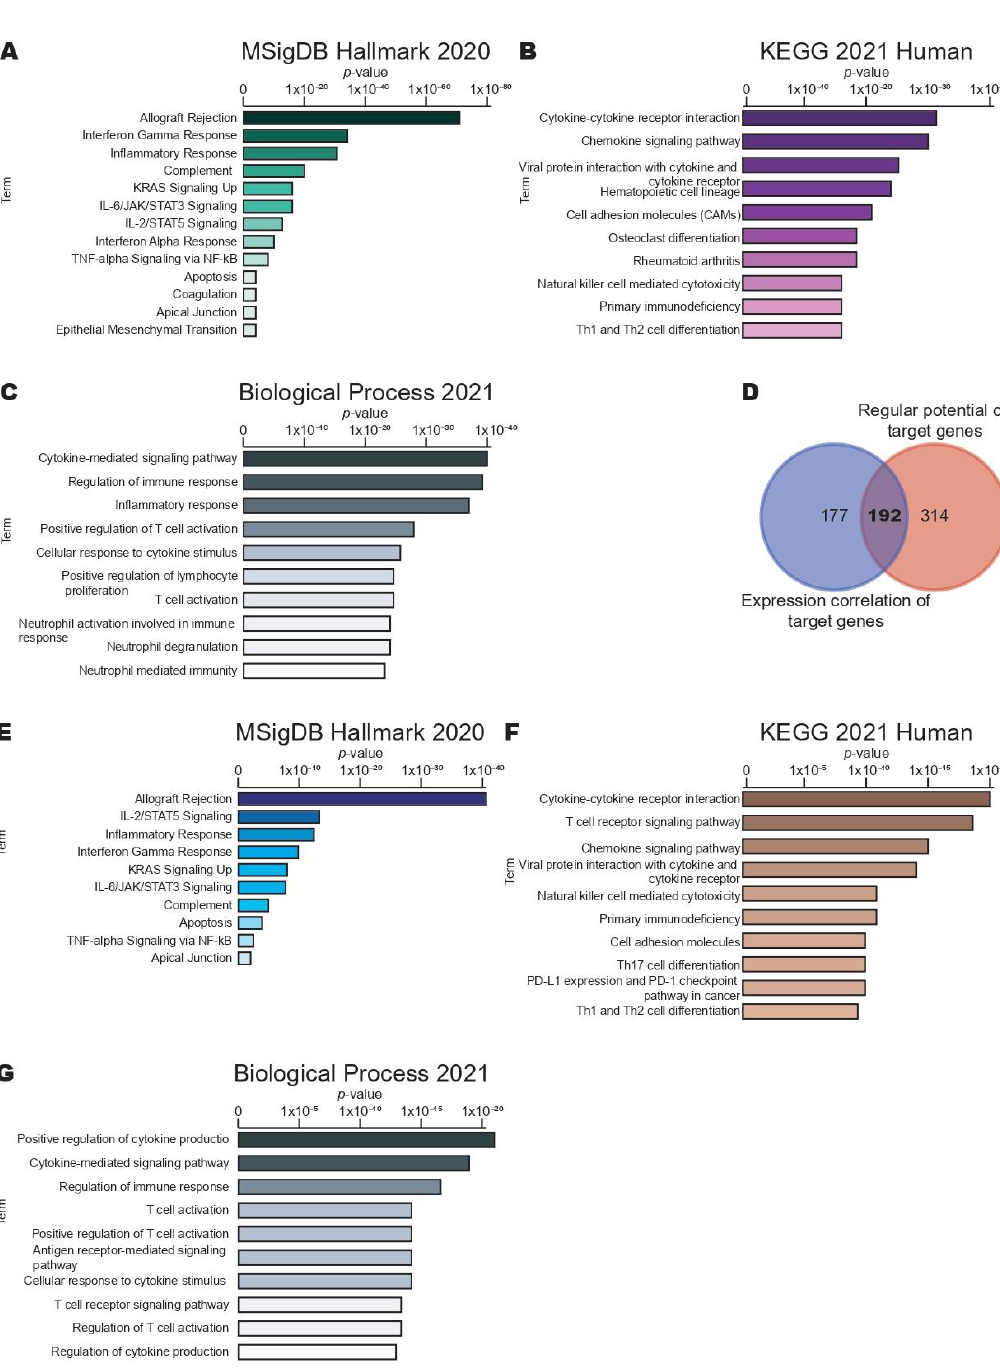
Figure 5. FLI-1 regulates the gene expression participating in the immune response in cervical cancer. ( A ) Identification of pathways according to genes that positively correlate with FLI-1 using the MSigDB Hallmark 2020 library in the Enrich database. ( B ) Validation of identified pathways of genes that positively correlate with FLI-1 using the KEGG 2021 Human library in the Enrich database. ( C ) Identification of the biological processes of genes that positively correlate with FLI-1 using the Biological Process 2021 library in the Enrich database. ( D ) Identification of genes in common considering the regular potential and expression correlation of target genes using the CISTROME database. ( E ) Identification of pathways of genes identified in ( D ) using the MSigDB Hallmark 2020 library in the Enrich database. ( F ) Validation of the identified pathways of genes selected in ( D ) using the KEGG 2021 Human library in the Enrich database. ( G ) Identification of biological processes of genes identified in ( D ) using the Biological Process 2021 library in the Enrich